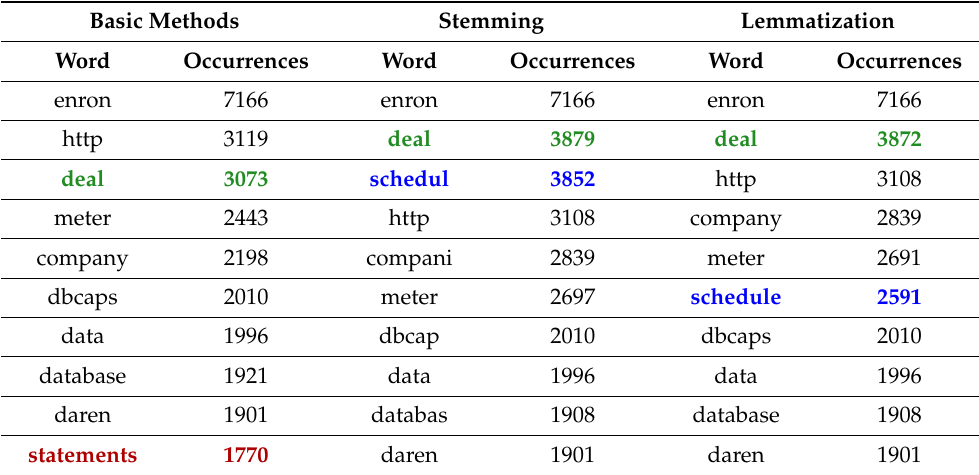
Table 10. Ten most common features for dataset